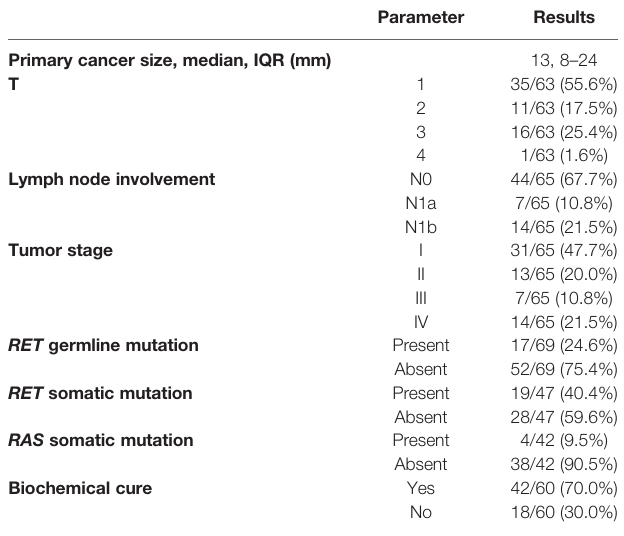
TABLE 1 | Clinicopathological characteristics of the MTC patients